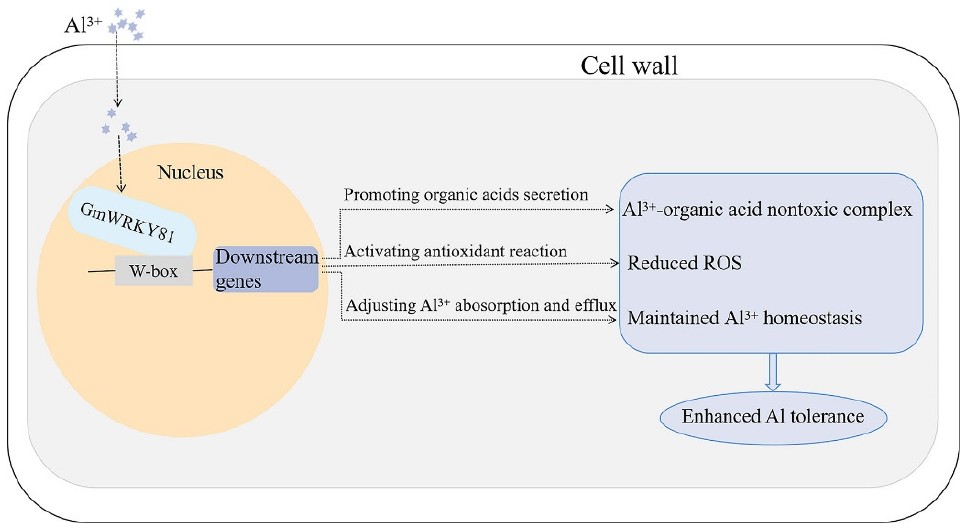
Figure 7. Schematic diagram of GmWRKY81 in regulating soybean Al tolerance. Toxic Al 3+ in cells activates the expression of GmWRKY81 and then affects the transcription of downstream genes participating in organic acid secretion, antioxidant reactions and Al 3+ absorption and efflux processes, thereby accelerating the combination of the nontoxic Al 3+ –organic acid complex, reducing excessive reactive oxygen species (ROS) and maintaining Al 3+ homeostasis. In these ways, GmWRKY81 confers enhanced Al tolerance to soybean.